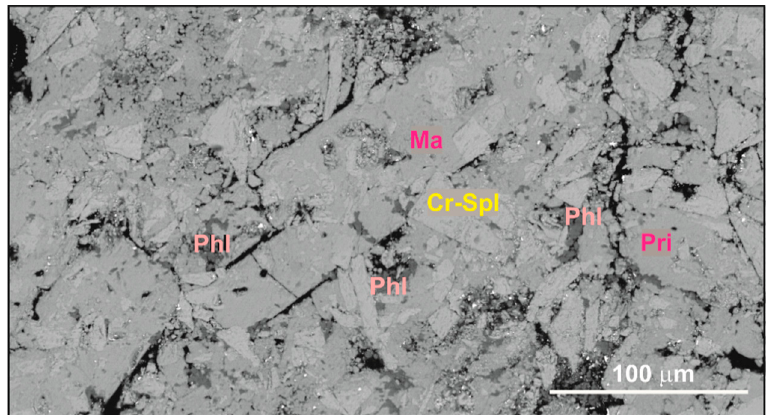
Figure 5. Phlogopite coexisting with mathasite and priderite in the run products of interaction of Cr-bearing spinel and rutile with the fluid H 2 O–CO 2 –K 2 CO 3 at 5 GPa [98]. Ma—mathiasite, Pri—priderite, all other mineral abbreviations are from [48].